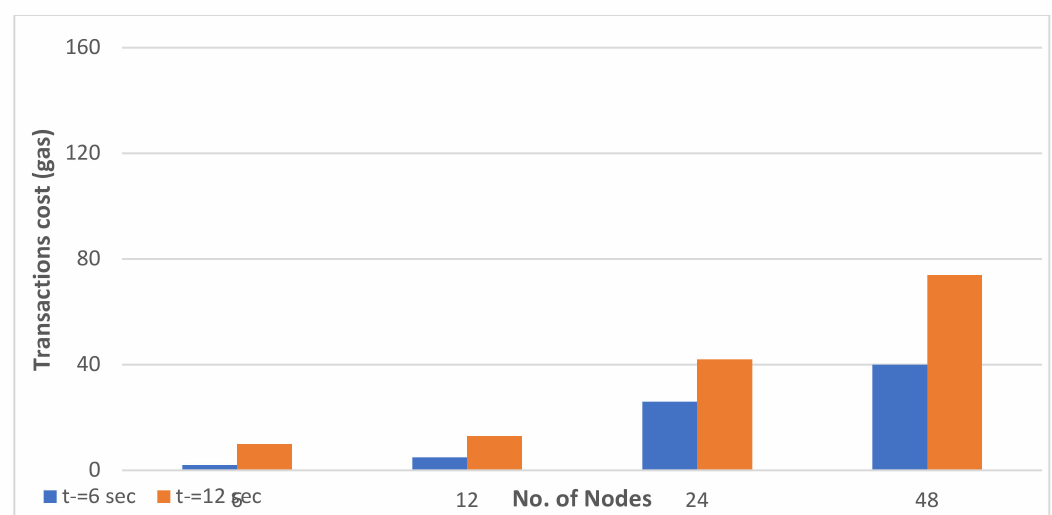
Figure 8. Transaction cost for gateway-type BIoT architecture.